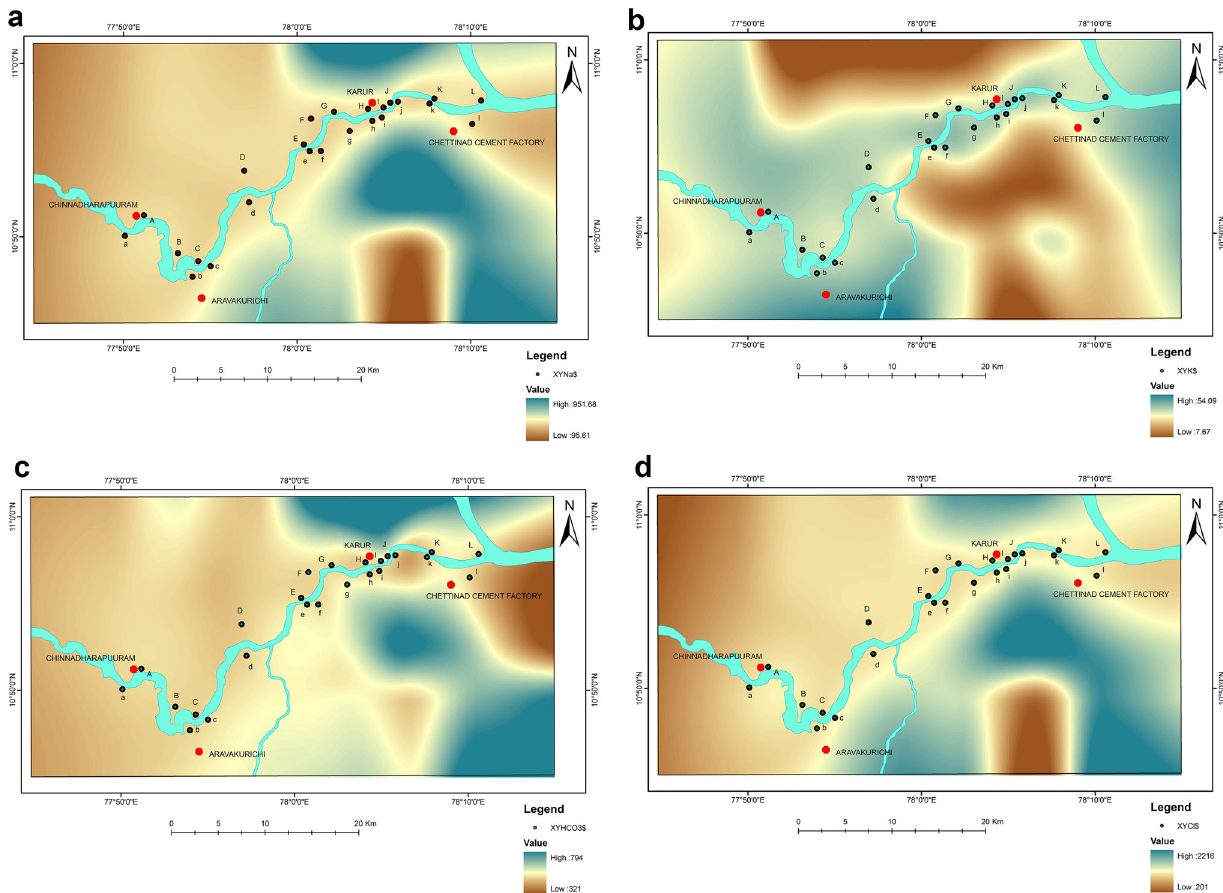
Fig. 4 a – d Spatial distribution of Na, K, HCO 3, and Cl in groundwater